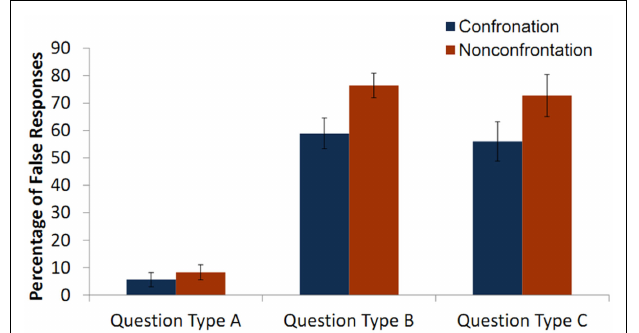
FIGURE 3 | Mean percentage of false claims across conditions. For illustration purposes, this graph shows the mean percentage of false claims across question type and confrontation. In the confrontation condition participants gave 58.95% (SE = 5.63) false responses to QuestionType B (the target object was only visible from the front view), 56.04% (SE = 7.15) false responses to QuestionType C (the target object was not present in the box), and 8.3% (SE = 2.76) false responses to QuestionType A (the target object was visible from the front and the back views). In the non-confrontation condition they gave 76.45% (SE = 4.49) false responses to QuestionType B, 72.74% (SE = 7.62) false responses to QuestionType C, and 5.6% (SE = 2.61) false responses to QuestionType A.